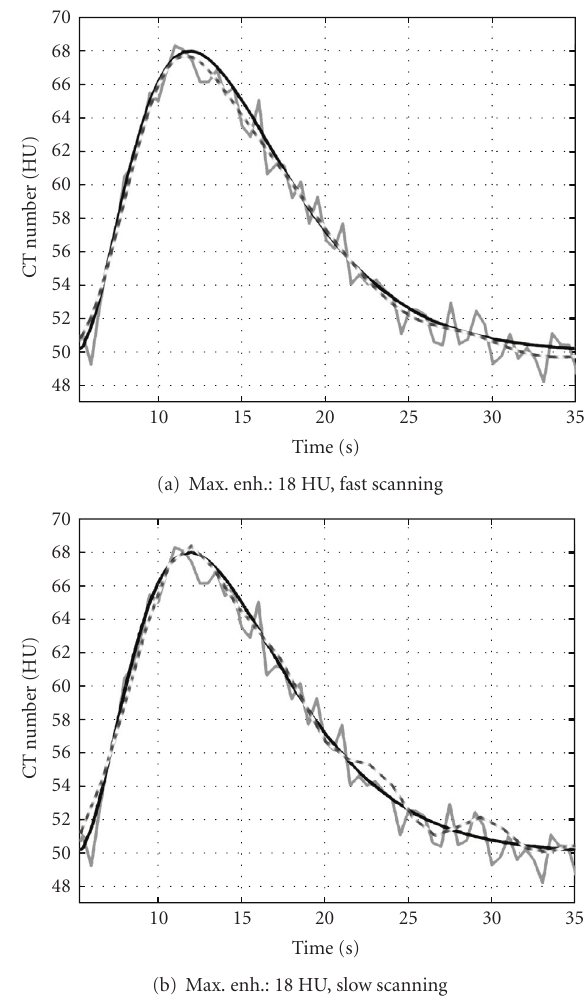
Figure 8: Time-attenuation curves of the inserts with maximum enhancement 18HU. (a) Fast-scanning, (b) slow-scanning. Black curves: phantom value, grey curves: values obtained with the reference protocol, and dashed curves show the value of the reconstruction with